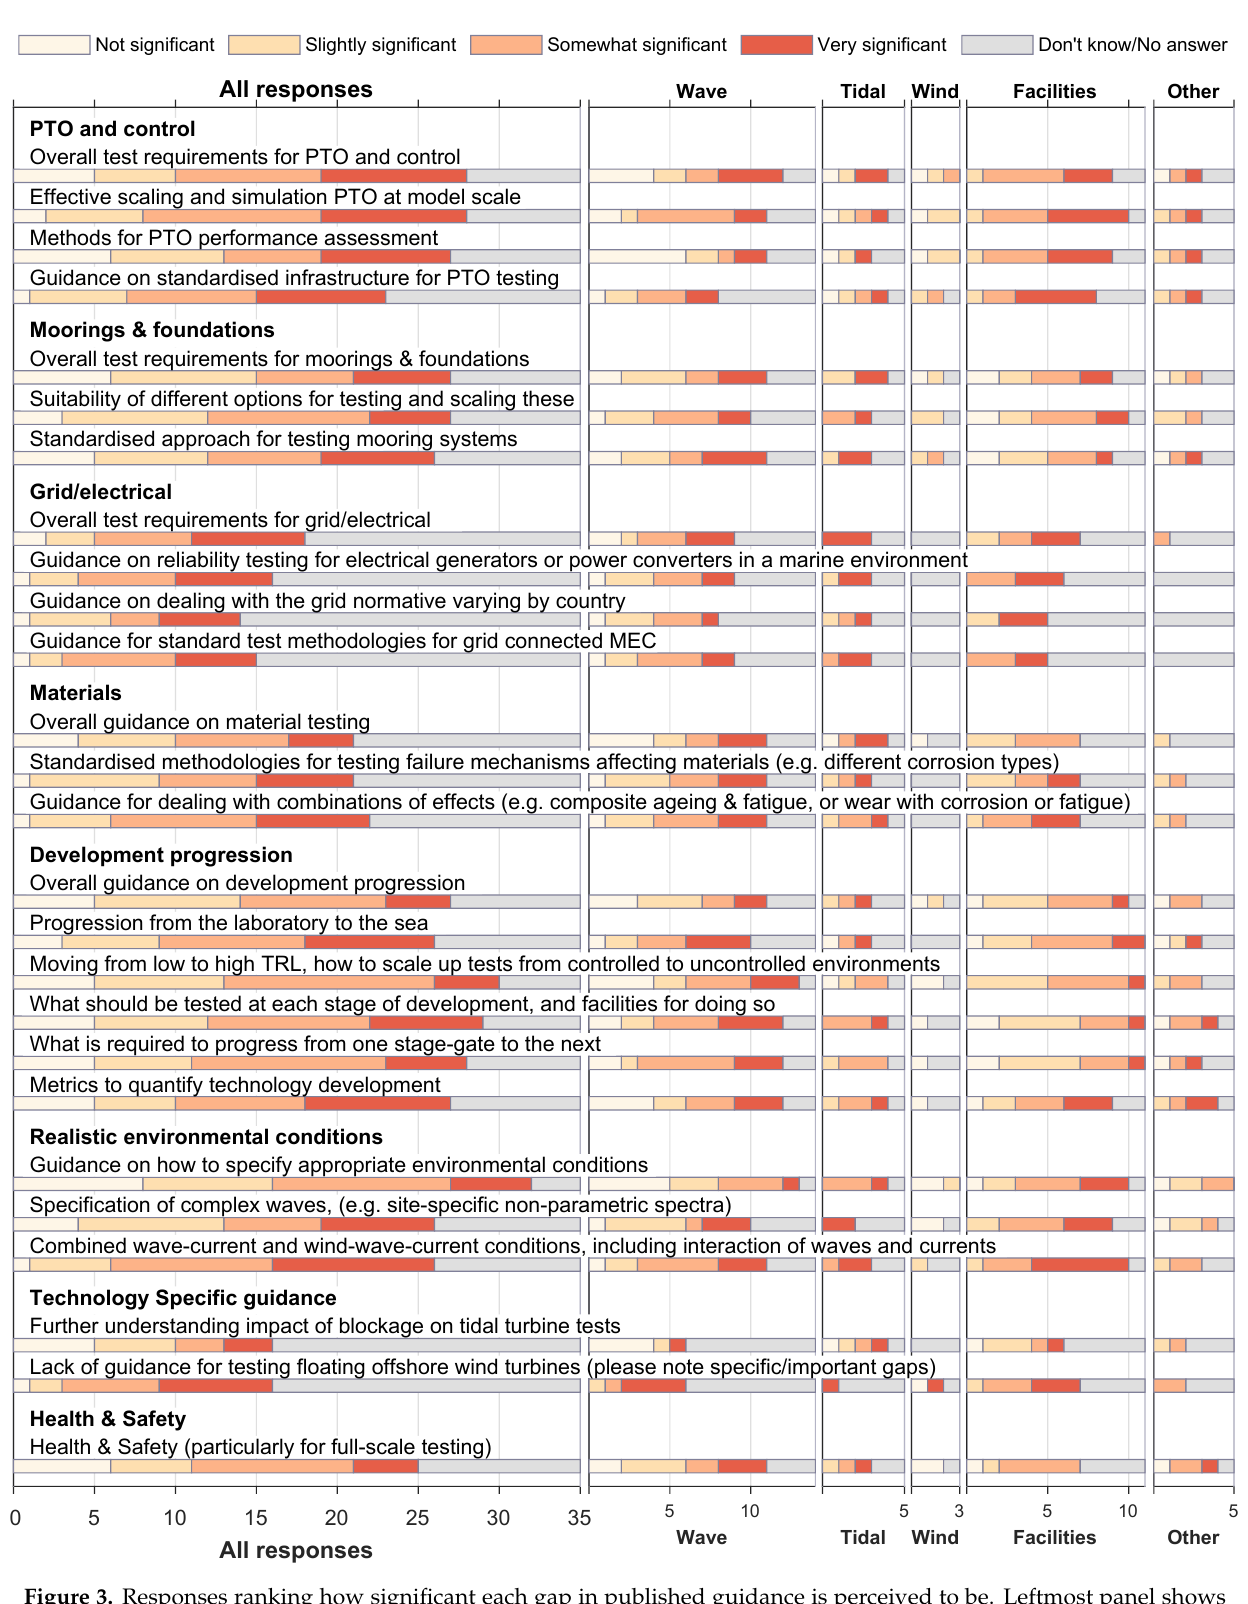
Figure 3. Responses ranking how significant each gap in published guidance is perceived to be. Leftmost panel shows all responses; other panels show these responses split by wave/tidal/offshore wind technology developers, test facility managers, and others. X-scales equal between all